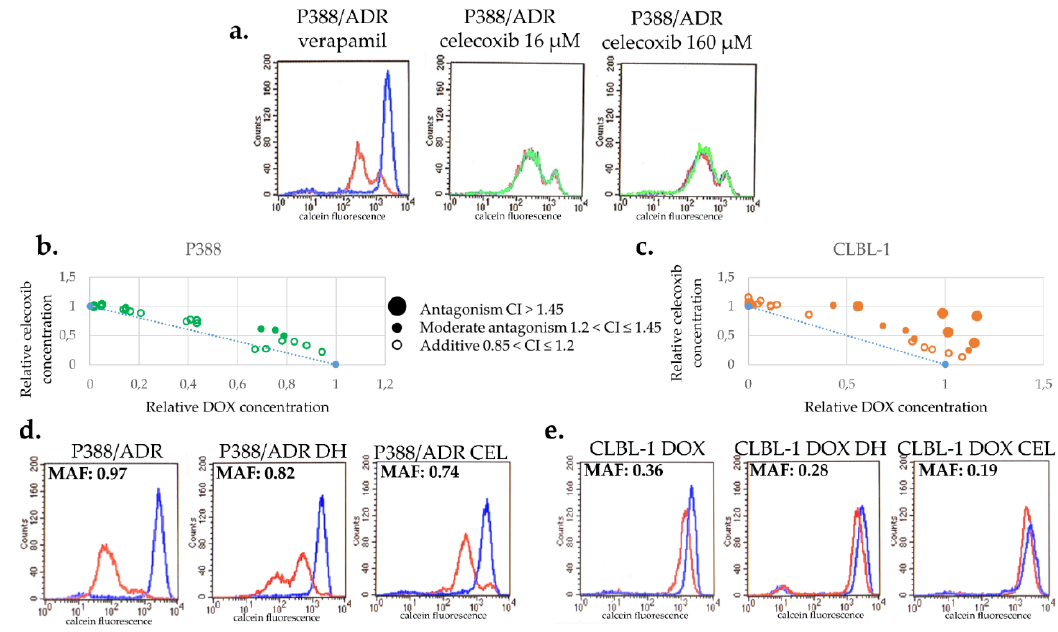
Figure 5. Celecoxib is not a Pgp inhibitor and does not increase the toxicity of DOX. ( a ) In contrast to verapamil (blue), a known Pgp inhibitor, 16–160 µ M CEL (green) does not inhibit the function of Pgp. ( b , c ) CEL does not show synergistic toxicity with DOX in P388 ( b ) or in CLBL-1 ( c ) cells. ( d , e ) Effect of CEL treatment on MDR in Pgp-expressing P388/ADR ( d ) and CLBL-1 D ( e ). CEL treatment resulted in a more pronounced reduction of MAF in Pgp-expressing P388/ADR ( d ) and CLBL-1 D ( e ) cells than drug holiday (DH).